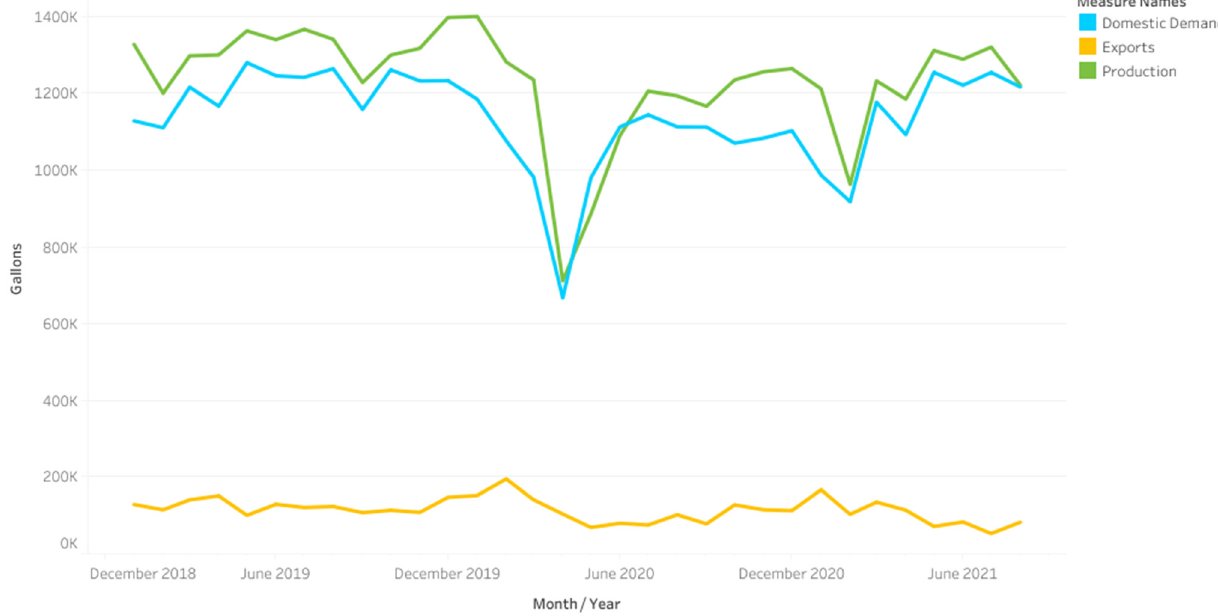
Figure 1. US supply and demand of ethanol (Source: Renewable Fuels Associations Monthly Ethanol Supply & Demand).